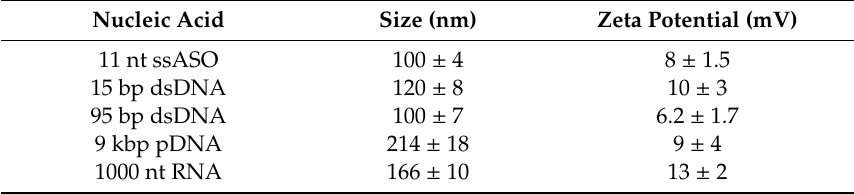
Table 1. Size and zeta potential of polyethylenimine (PEI) polyplexes.